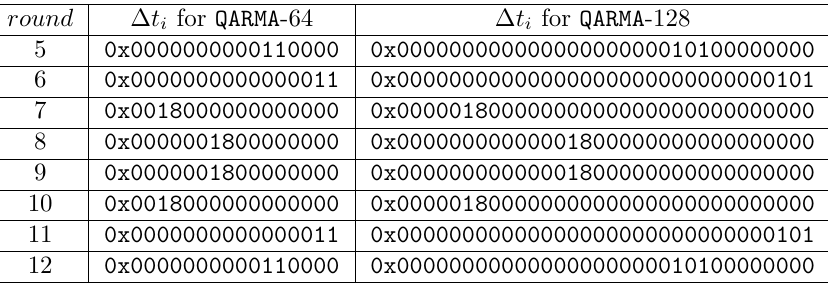
Table 8: Difference of Round Tweak for No. 3 Distinguisher